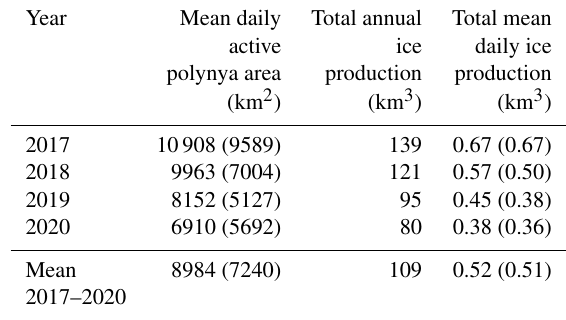
Table 2. Estimates of mean daily active polynya area, total annual ice production, and mean daily ice production during the winters of 2017–2020 and for the daily mean of the period. Numbers in brackets indicate the standard